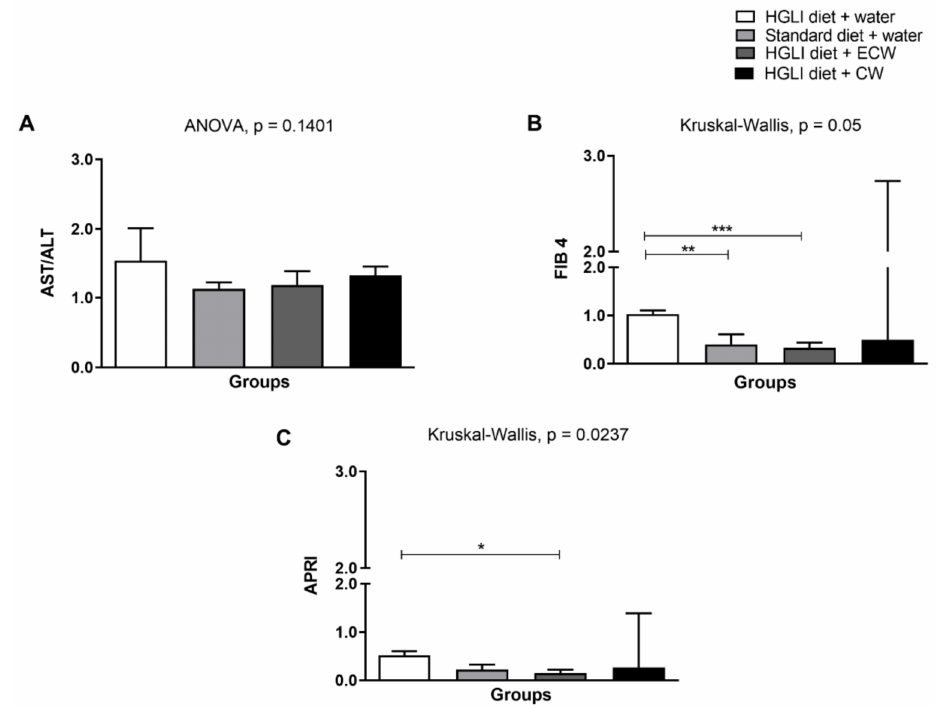
Figure 2. Assessment of liver damage scores. ( A ) AST/ALT ratio. ( B ) FIB-4. ( C ) APRI. Experimental groups: (1) HGLI diet + water; (2) Standard diet + water; (3) HGLI diet + ECW; (4) HGLI diet + CW. Values were expressed as mean and standard deviation. The Kolmogorov-Smirnov test was used to evaluate the normality of the data. AST/ALT ratio presented parametric distribution, so the ANOVA test with Tukey’s post-hoc test was used to determine the significant differences.FIB-4 and APRI showed non-parametric distribution, so the Kruskal-Wallis test and Dunn’s post-test were used to detect significant differences. * Values were significantly different for APRI score, according to Kruskal-Wallis and Dunn’s post-hoc test ( p < 0.05). ** Values were significantly different for FIB 4 score, according to Kruskal-Wallis and Dunn’s post-hoc test ( p < 0.001). *** Values were significantly different for FIB 4 score, according to Kruskal-Wallis and Dunn’s post-hoc test ( p < 0.0001). Mean and standard deviation. HGLI: high glycemic index and glycemic load diet; AST: oxalacetic glutamic transaminase; ALT: alanine transaminase; FIB-4: Fibrosis-4 Index for Liver Fibrosis; APRI: AST to Platelet Ratio Index; ECW trypsin inhibitor isolated from tamarind seeds encapsulated with whey protein isolate and chitosan (1:2:2 w/w/w ); CW: chitosan–whey protein isolate nanoparticles (2:2 w / w